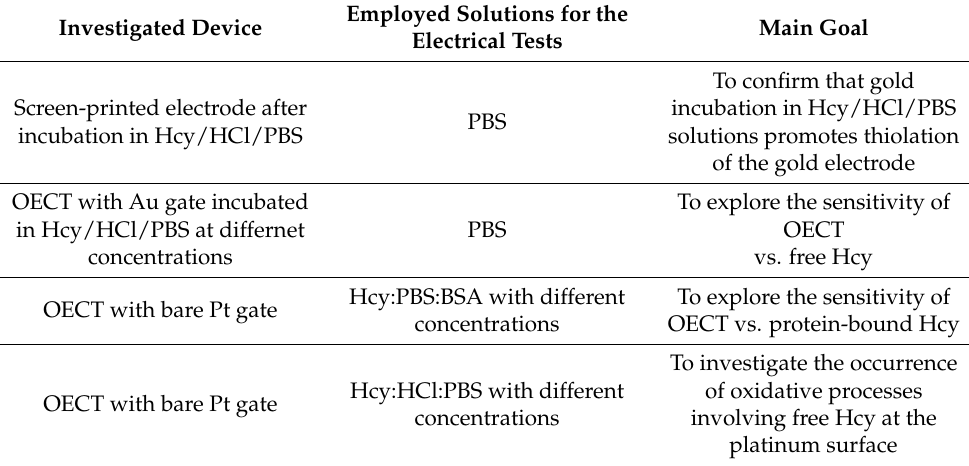
Table 2. List of the performed electrical